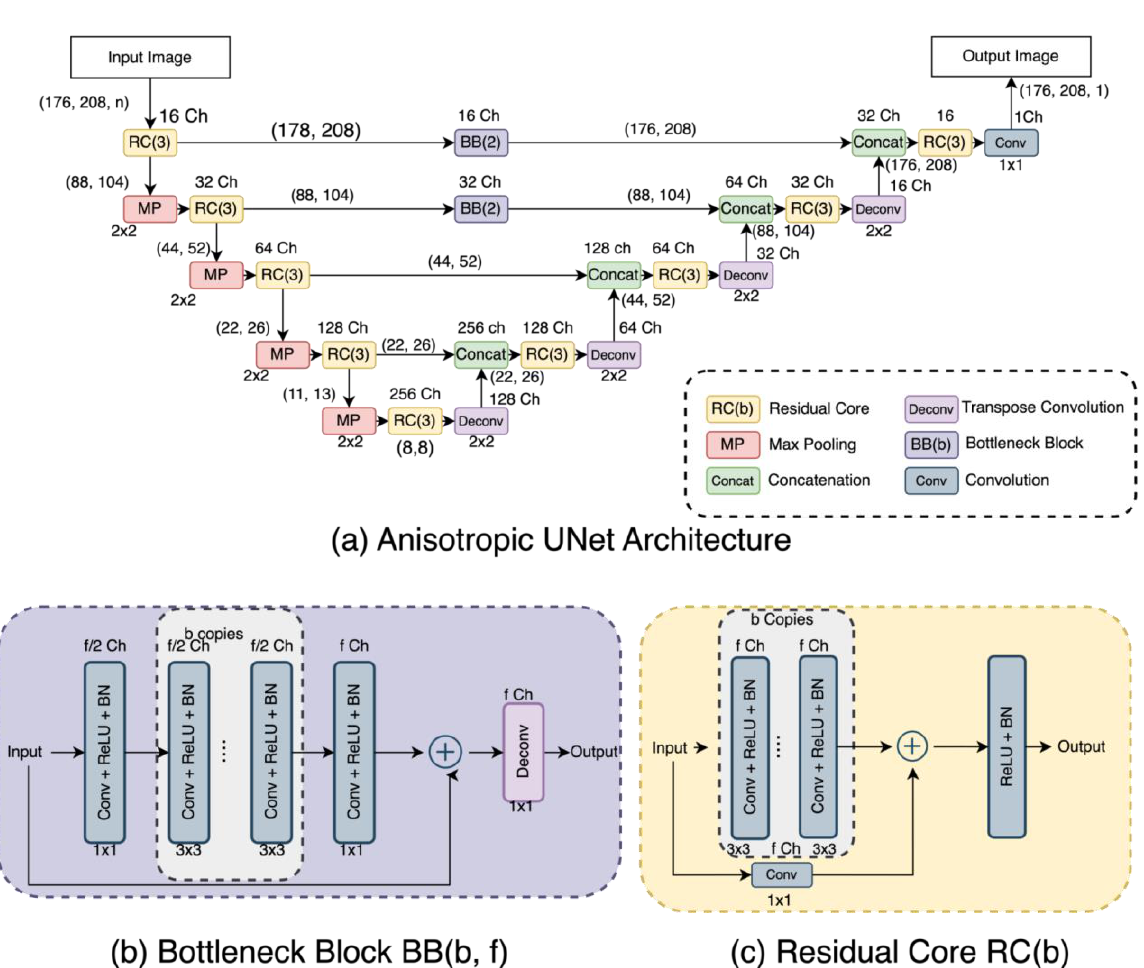
Figure 4. ( a ) Anisotropic UNet (AUNet) Architecture, ( b ) Bottleneck Block, and ( c ) Residual Core.